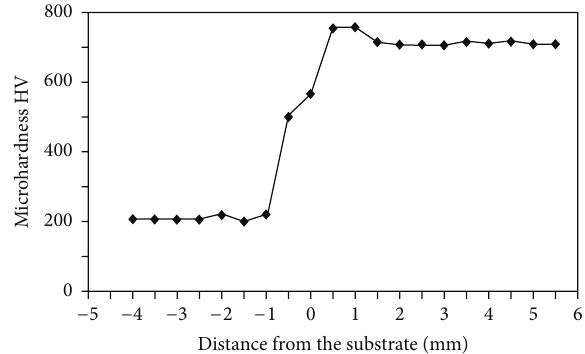
Figure 7: Microhardness profile of the multilayer laser cladding